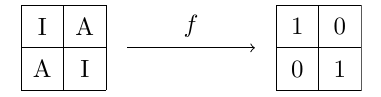
Figure 4. Classification of pixels using a probability